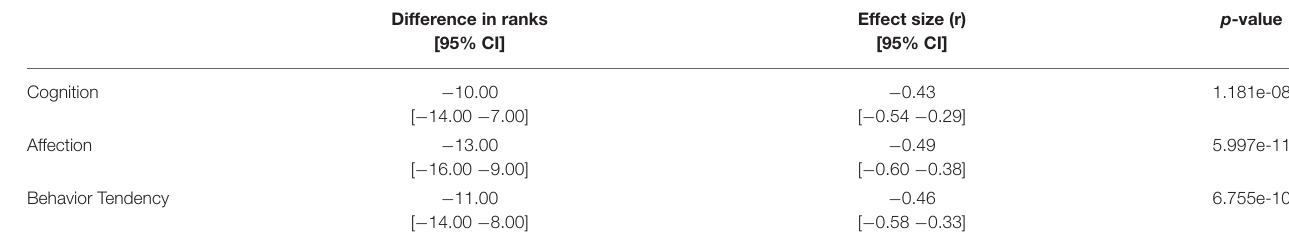
TABLE 9 | Confidence interval and effect size of each